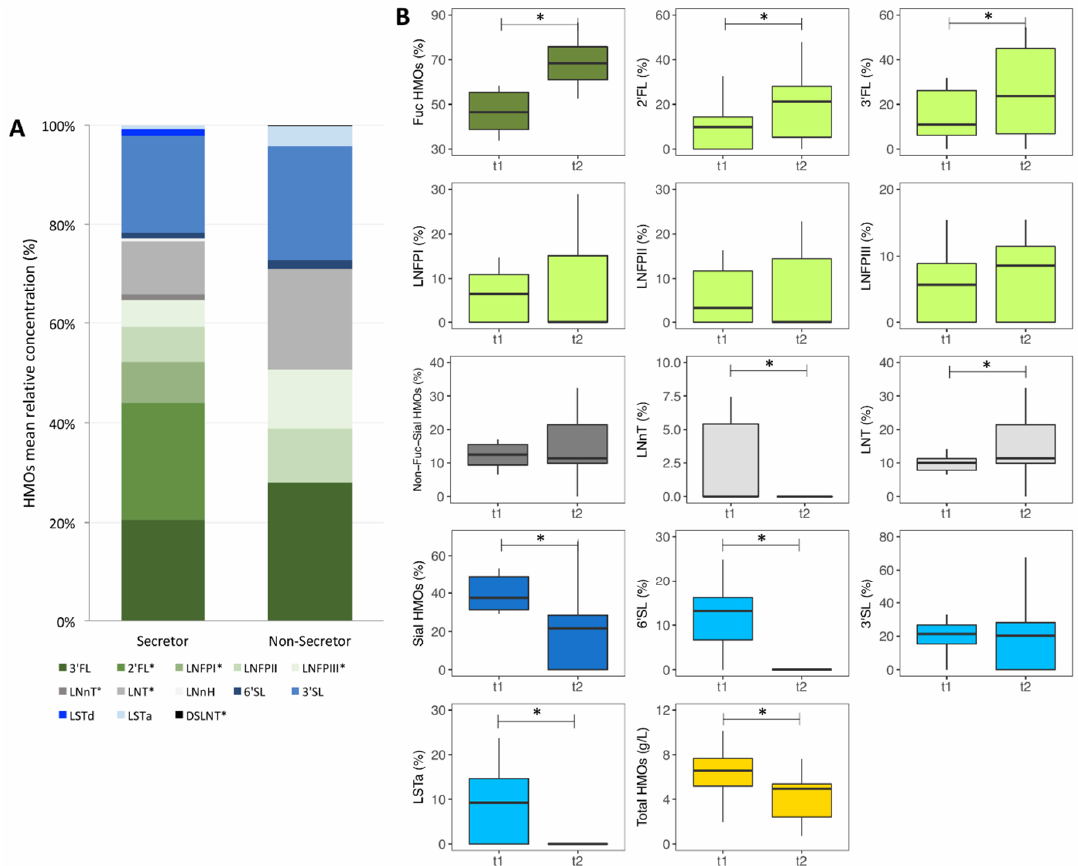
Figure 1. Concentration of human milk oligosaccharides (HMOs) in breast milk samples of Kenyan mothers. ( A ) Mean relative concentration of HMOs in breast milk samples of Kenyan mothers ( n = 75), by secretor status. ( B ) Absolute concentration of total HMOs (g/L) and relative concentration (%) of single HMOs, Sial HMOs (total sialylated HMOs), Fuc HMOs (total fucosylated HMOs), Non-Fuc-Sial HMOs (total non-fucosylated and non-sialylated HMOs) in breast milk samples of Kenyan mothers ( n = 16) over 3 months of lactation. 2′FL, 2-fucosyllactose; 3′FL, 3-fucosyllactose; LNFPI, lacto-N-fucopentaose I; LNFPII, lacto-N-fucopentaose II; LNFPIII, lacto-N-fucopentaose III; LNnT, lacto-N-neotetraose; LNT, lacto-N-teraose; LNnH, lacto-N-neohexaose; 6′SL, 6-sialyllactose; 3′SL, 3-sialyllactose; LSTd, sialyllacto-N-tetraose d; LSTa, sialyllacto-N-tetraose a; and DSLNT, disialyl-lacto-N-teraose. Differences between groups and time points were tested using Wilcoxon rank-sum tests and Wilcoxon signed-rank tests, respectively; * p < 0.05, ° p < 0.10.